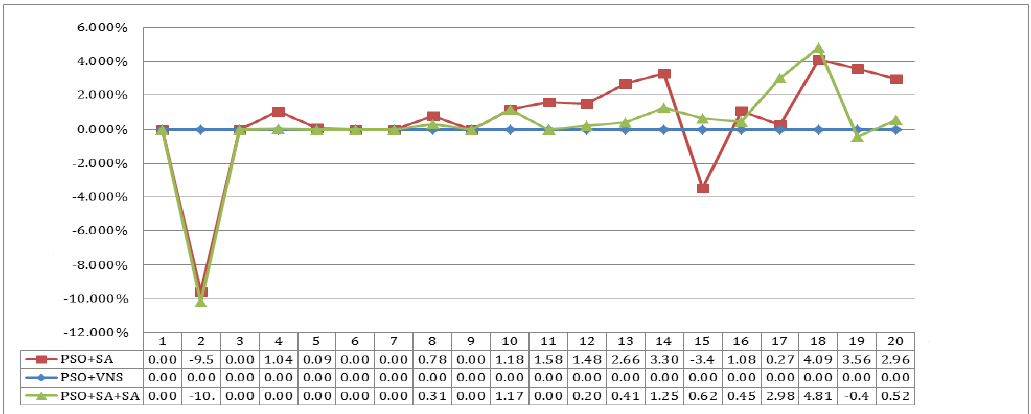
Figure 8. Experiment results of small-sized